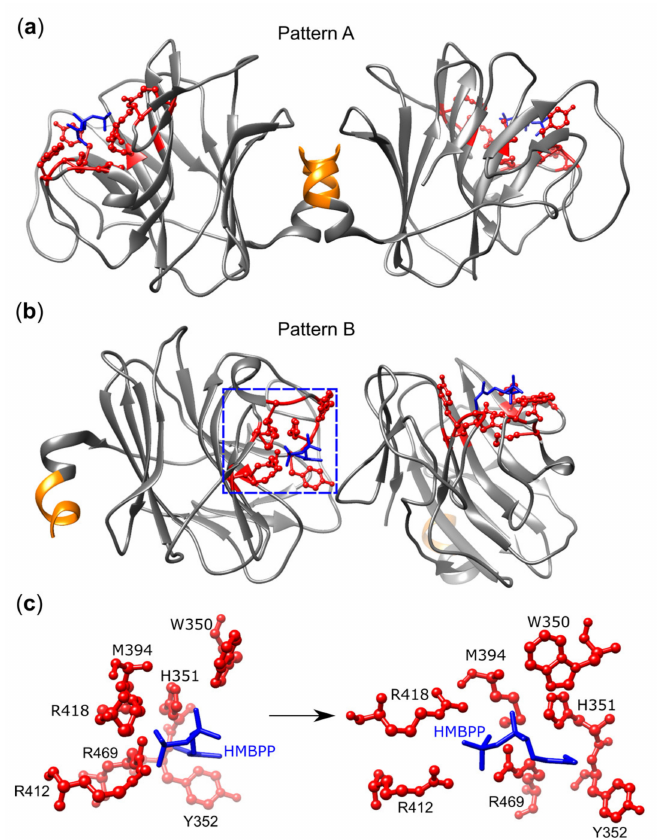
Figure 5. ( E )-4-hydroxy-3-methyl-but-2-enyl pyrophosphate (HMBPP) binding to the BTN3A1